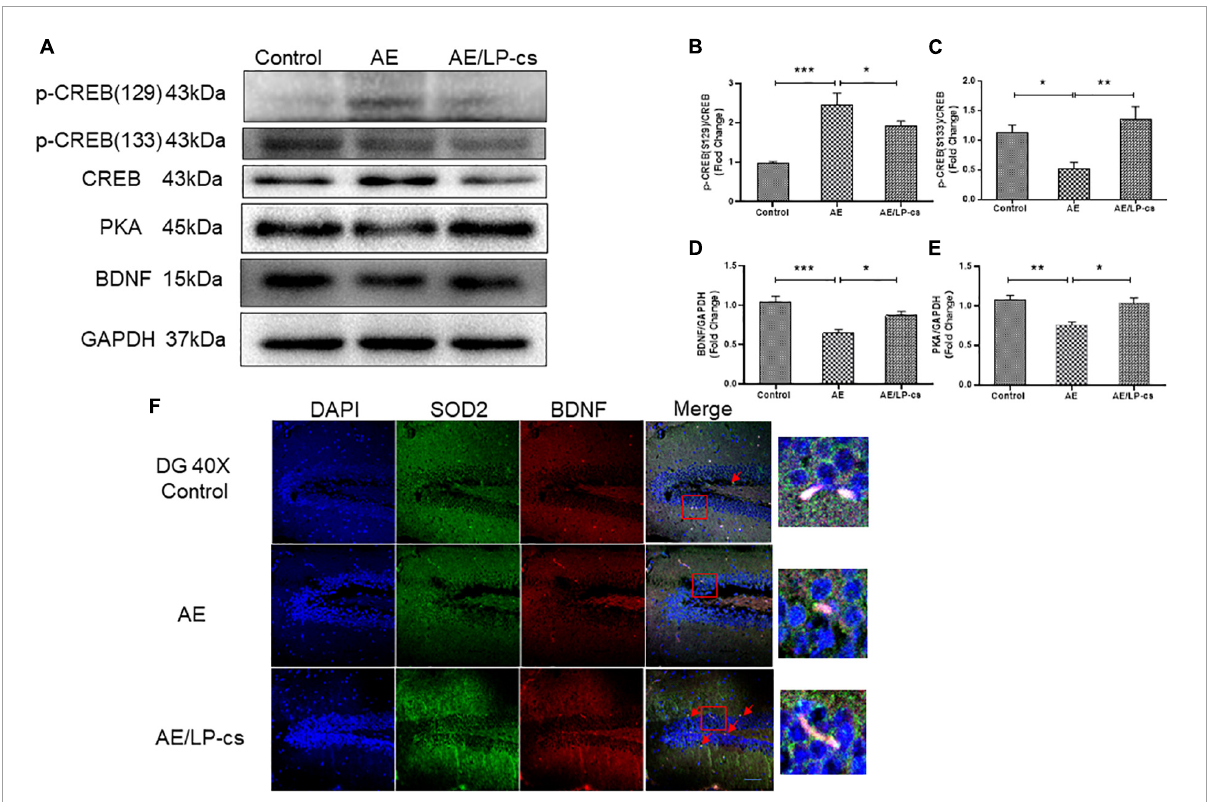
FIGURE6 Lactobacillus plantarum culture supernatants ameliorates alcohol-induced suppression of CREB activity and BDNF expression. (A–E) Western blot and quantitative analysis of BDNF, PKA, p-CREB (S133), and p-CREB (S129), n = 5–10. (F) Co-immunofluorescence staining of BDNF and SOD2 in the DG of the hippocampus (scale bar, 15 µ m, n = 3–6). Control vs. AE and AE vs. AE/LP-cs, * p < 0.05, ** p < 0.01, *** p <